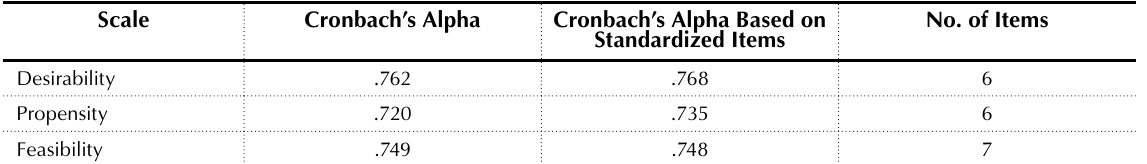
Table 1. Reliability Statistics